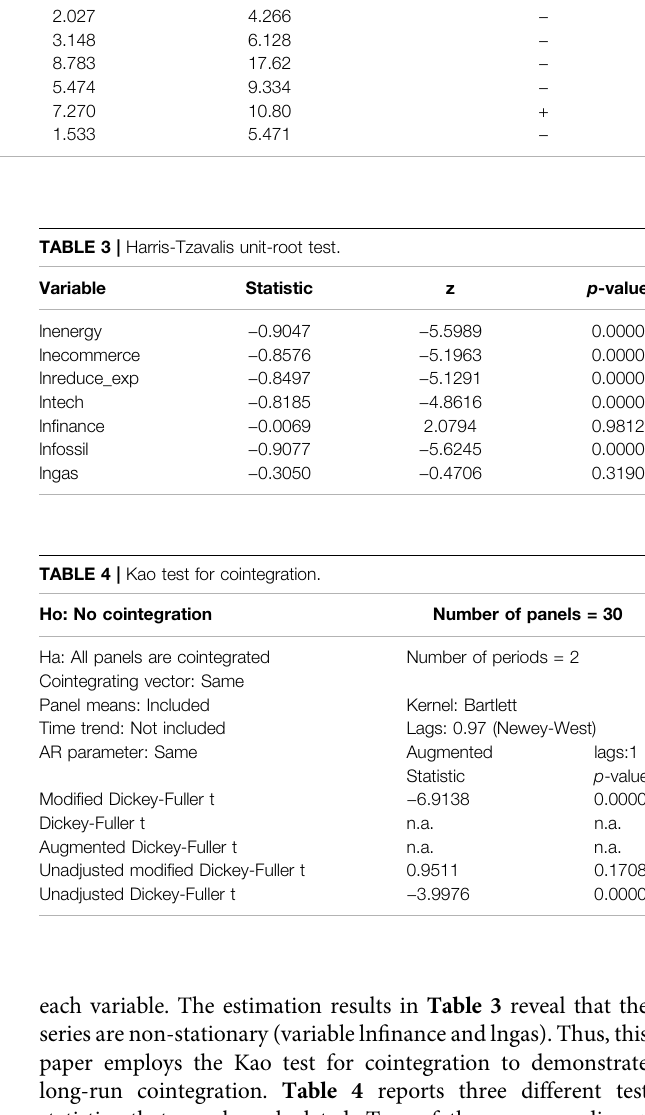
Table 5 re fl ects the preliminary results of the impact of